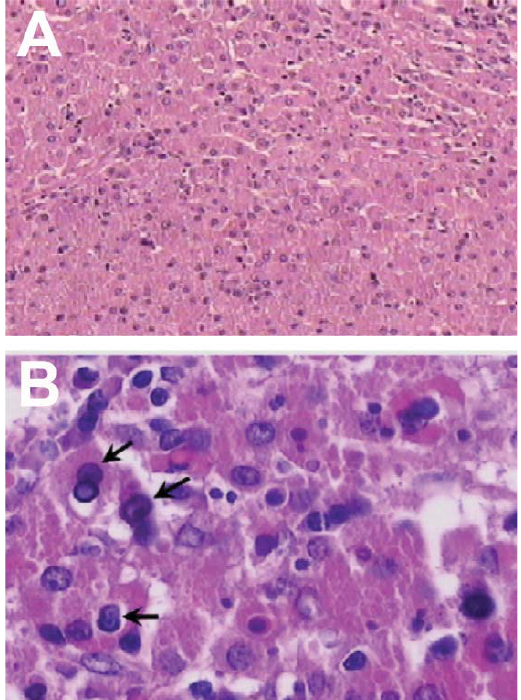
Figure 2 - (A) large macrophage cells with eosinophilic cytoplasm (histiocytes). (B) within the histiocytes as well as extracellularly in the stroma, rounded, concentrically layered, target or ring-like structures that were interpreted as Michaelis-Guttman bodies (arrows) H&E